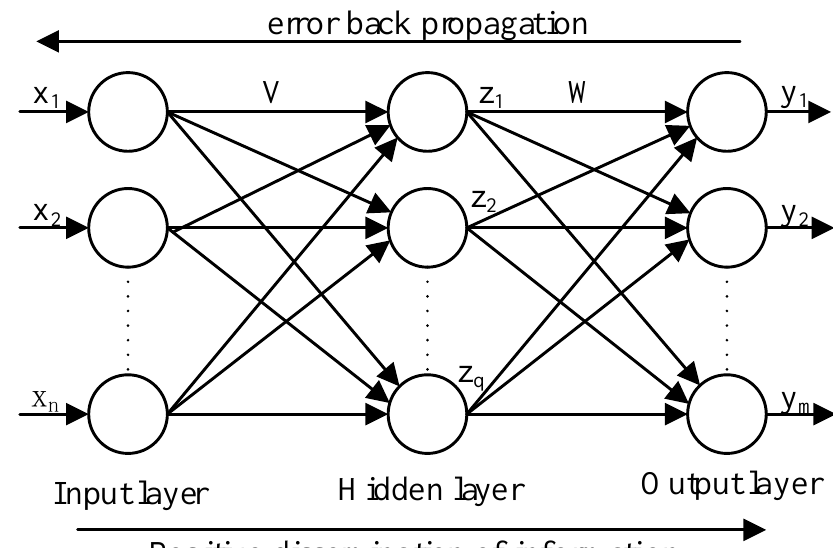
Figure 3. Structure diagram of three-layer BP neural network.